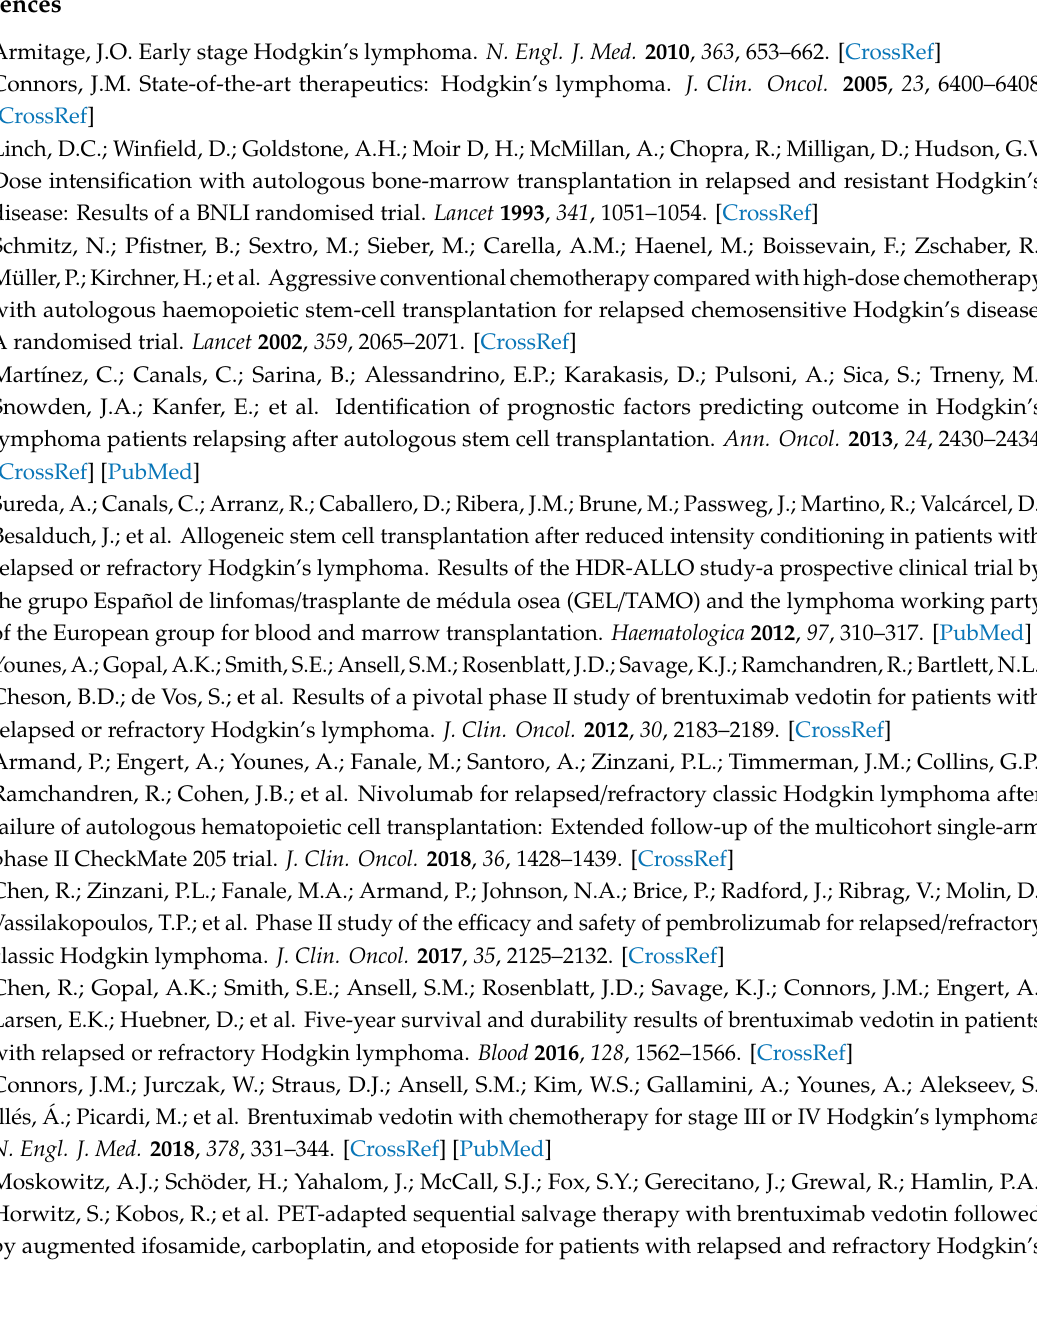
Figure S1: Treatment algorithim for Relapsed or Refractory Hodgkin Lymphoma after Auto-HCT; Table S1: Novel agents in relapsed / refractory (R / R) Hodgkin Lymphomas (HL) after autologous stem cell transplantation